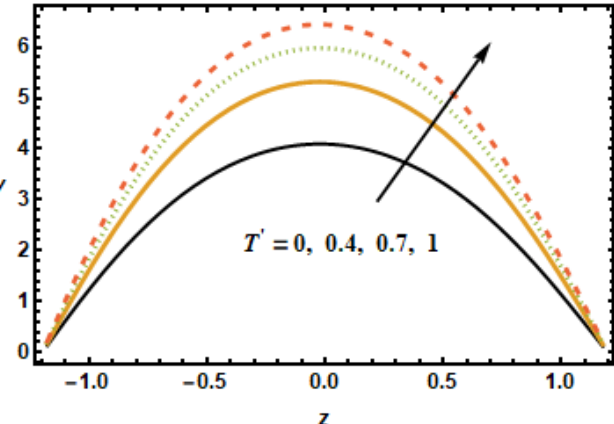
v on secondary slip